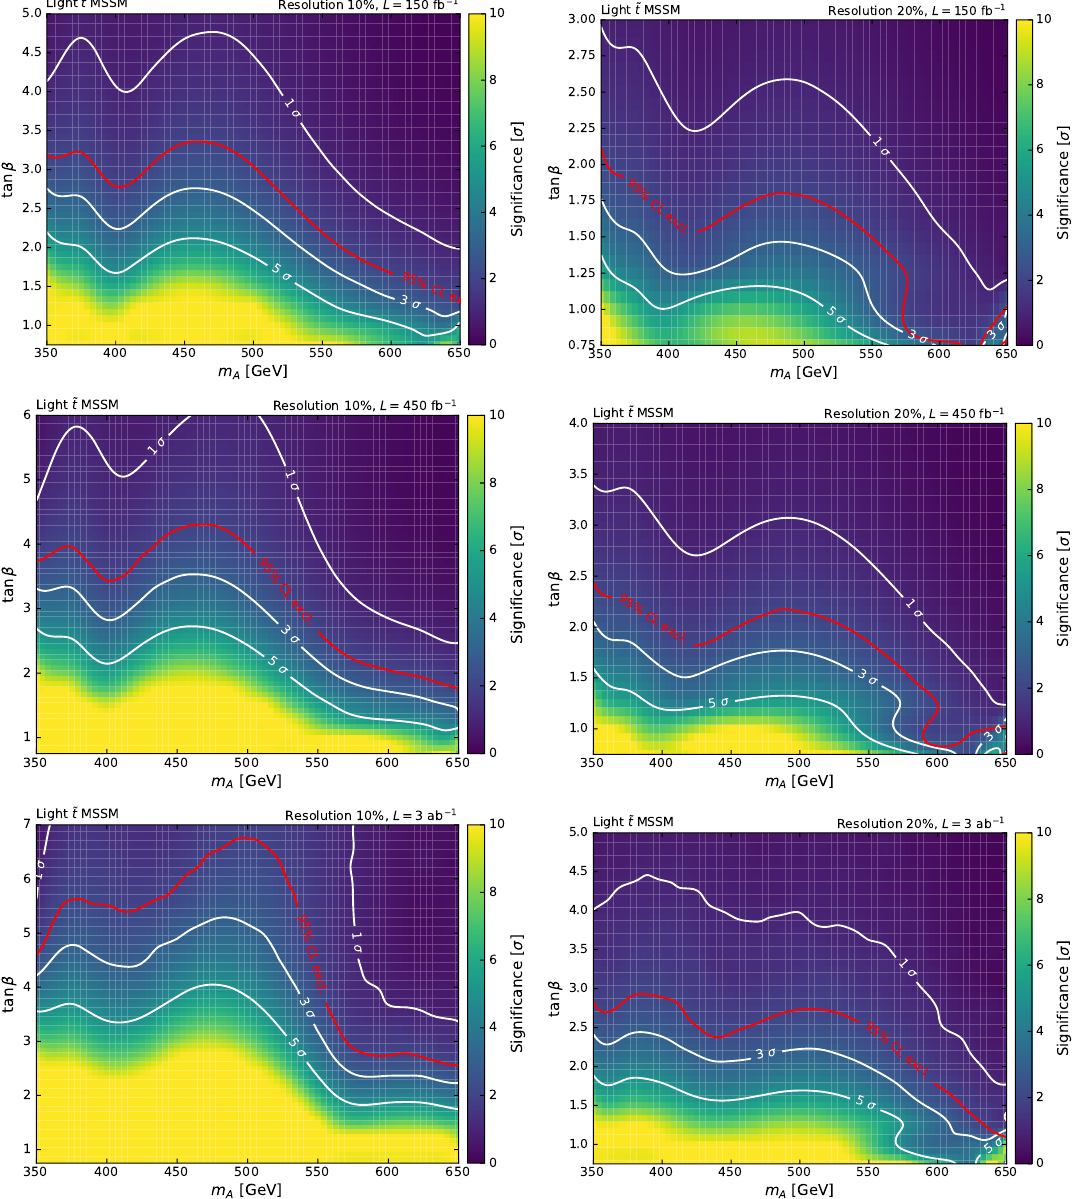
Figure 19 . Expected signi(cid:12)cance and exclusion potential for the light-stop MSSM benchmark in the same six experimental scenarios as considered in (cid:12)gure 10. Values of signi(cid:12)cance in excess of 10 (cid:27) are clipped. A resolution of 10% and 20% is assumed for the left- and the right-hand side plots,